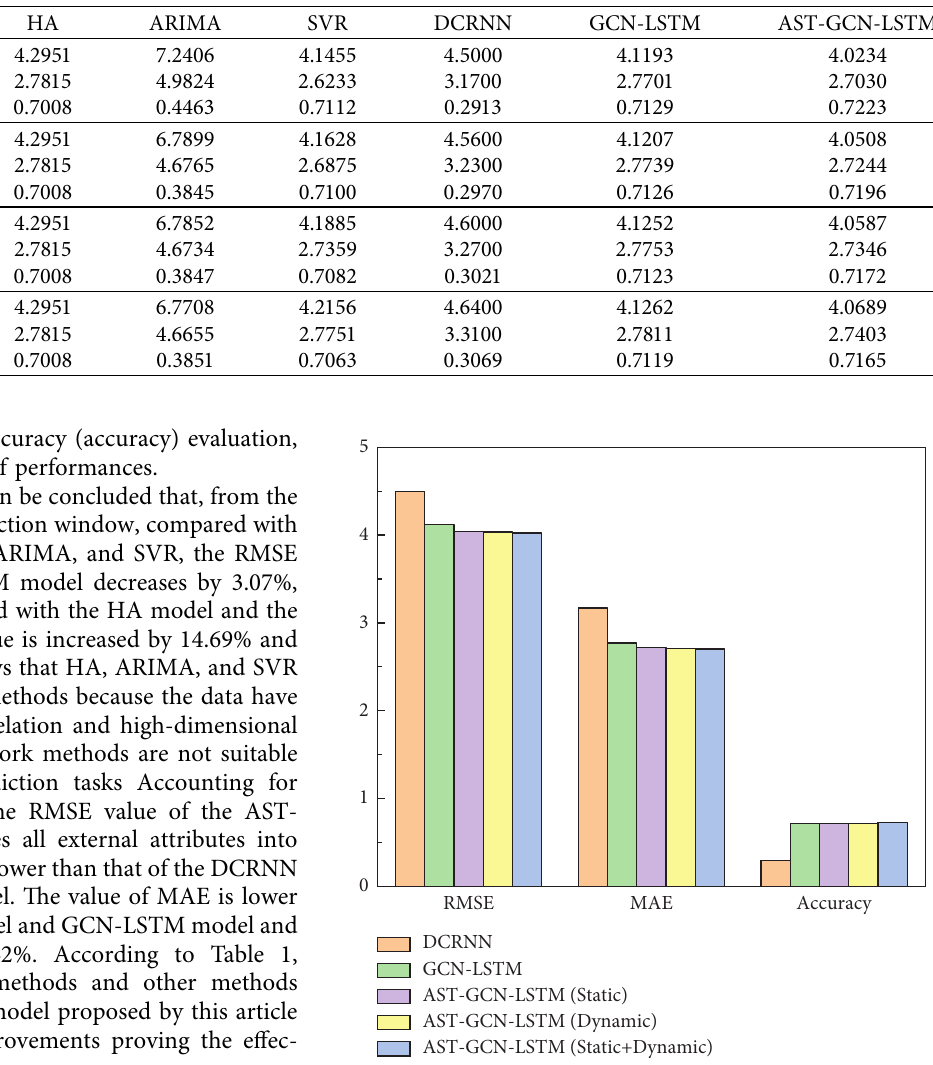
Table 1: Performance comparison of different methods.